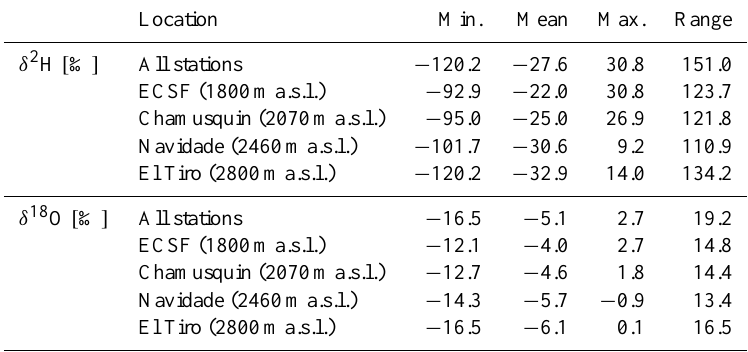
Table 2. Descriptive statistic of all 26 events